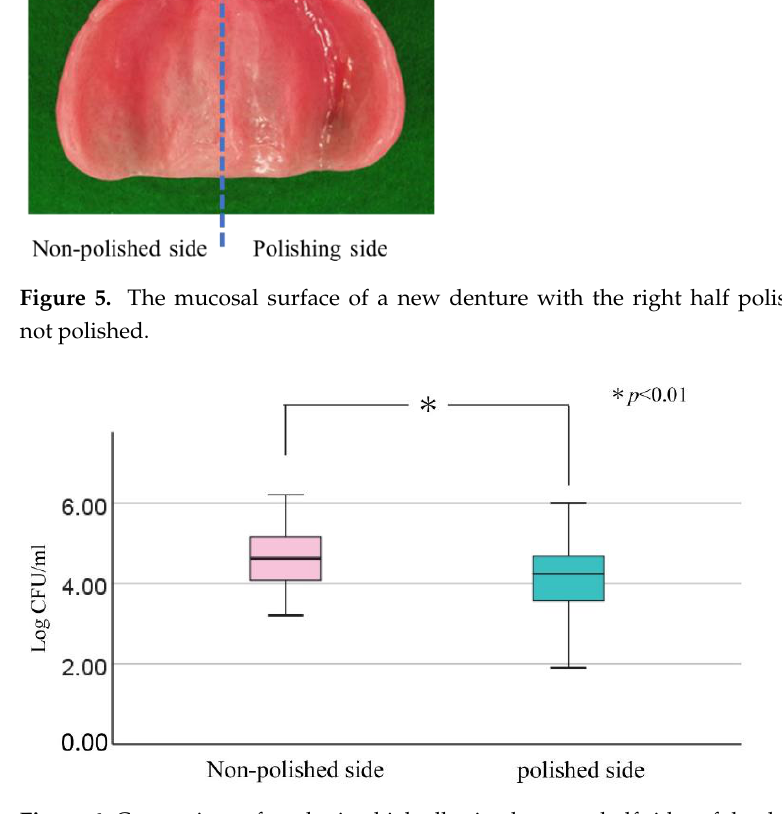
Figure 6. Comparison of total microbial adhesion between half sides of the denture mucosal surface with and without polishing. In each box plot, the central point represents the median, the rectangle gives the interval between the 25% and 75% percentiles. The whiskers represent the lowest and highest value in the 25% percentile minus 1.5IQR and 75% percentile plus 1.5IQR regions, respec- tively.